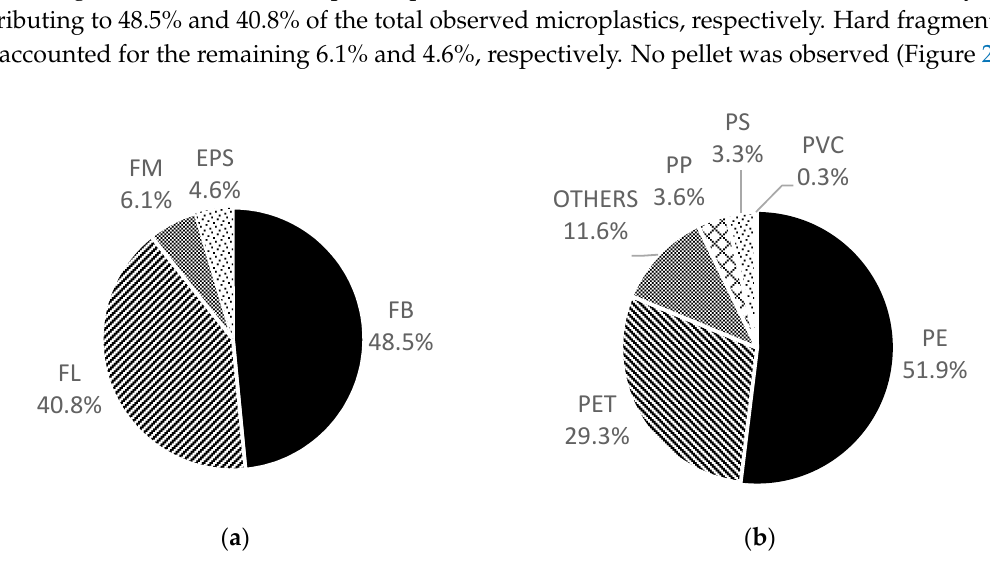
Figure 2. Proportion of microplastics by ( a ) type and ( b ) polymer.